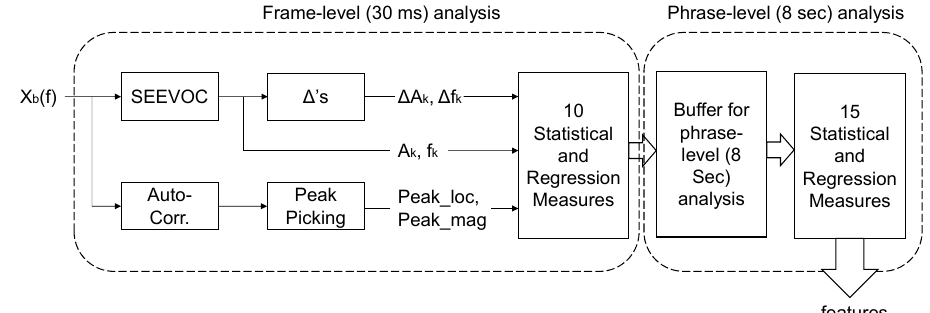
Figure 2. The proposed feature extraction method